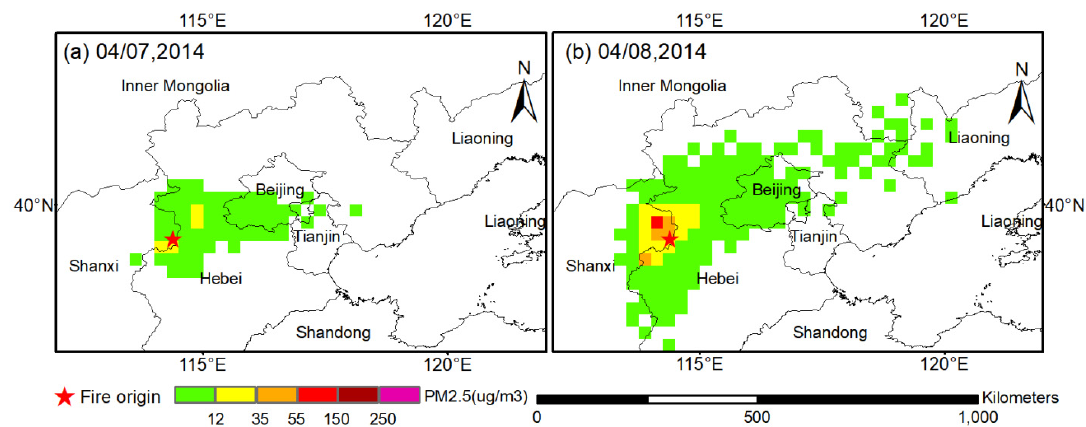
Figure 7. Same as Figure 3 except for the Baoding fire. Panels ( a – b ) are 7 and 8 April 2014, respectively.